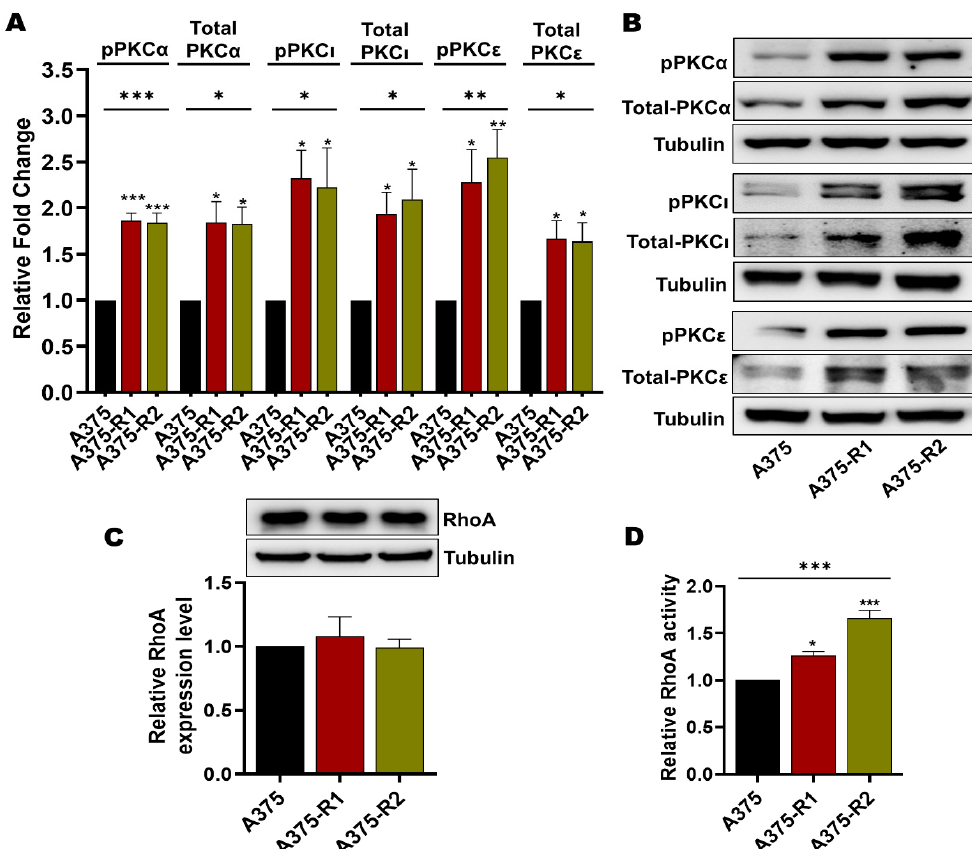
Figure 7. PKC and RhoA activity is enhanced in BRAFi-R melanoma cells. ( A ) Graph showing the densitometric analysis of PKC α , pPKC α , PKC ι , pPKC ι , PKC ε , and pPKC ε protein levels in BRAFi- sensitive and BRAFi-R A375 cells shown in B. These values were normalized to the value of the tubulin loading control from the same sample. The presented PKC/tubulin ratios were normalized to those in the corresponding BRAFi-sensitive cells and are given as relative fold changes. The data were calculated from 4 independent experiments and are presented as the means ± SEMs. ( B ) West- ern blot analysis showing the endogenous protein levels of PKC α , pPKC α (Thr-638/641), PKC ι , pPKC ι (T555 + 563), PKC ε , and pPKC ε (Ser-729) in BRAFi-sensitive and BRAFi-R A375 cells. Tubu- lin was used as the loading control. Representative blots from 4 independent experiments are shown. ( C ) Western blot showing RhoA protein expression in BRAFi-sensitive and BRAFi-R A375 melanoma cells. Graph below the blot show the densitometric results obtained from the value of RhoA protein expression and the tubulin loading control from the same sample. The generated RhoA/tubulin ratios were normalized to those in the corresponding BRAFi-sensitive cells and are presented as relative RhoA expression levels. The data were calculated from 4 independent experi- ments, and the values are presented as the means ± SEMs. ( D ) Graph showing RhoA activity in BRAFi-sensitive and BRAFi-R A375 melanoma cells as measured by a G-LISA kit. Activity levels were normalized to those in BRAFi-sensitive cells and plotted from 4 independent experiments and are given as the means ± SEM. Statistical significance was estimated using ANOVA with Dunnett’s post hoc test for multiple comparisons; * p < 0.05, ** p < 0.01, *** p < 0.001. Our next step was to analyze the level of total RhoA in BRAFi-sensitive and BRAFi- R melanoma cells by Western blotting. Our results revealed that BRAFi-sensitive A375, A375-R1 and A375-R2 melanoma cells exhibited similar expression levels of RhoA (Figure 7C). However, when we measured RhoA activity [43], we found that both A375-R1 and